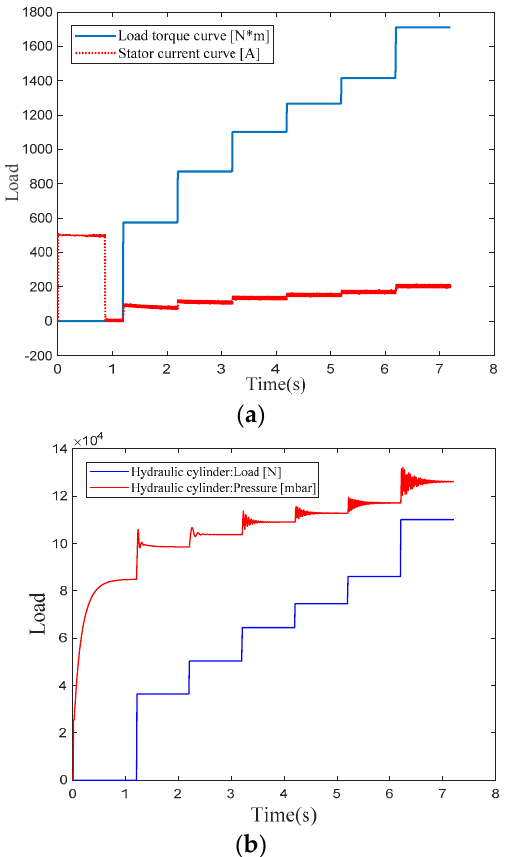
Figure 5. ( a ) Current change curves under different loads and ( b ) Pressure change curve under different loads. Table 3. Coal and rock impedance identification database.